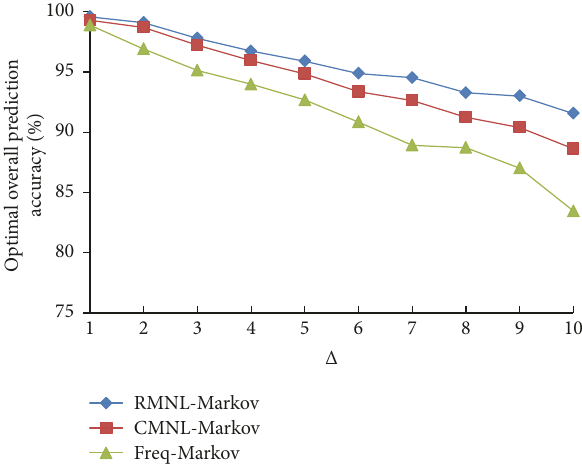
Figure 8: Prediction accuracy and number of transition steps.